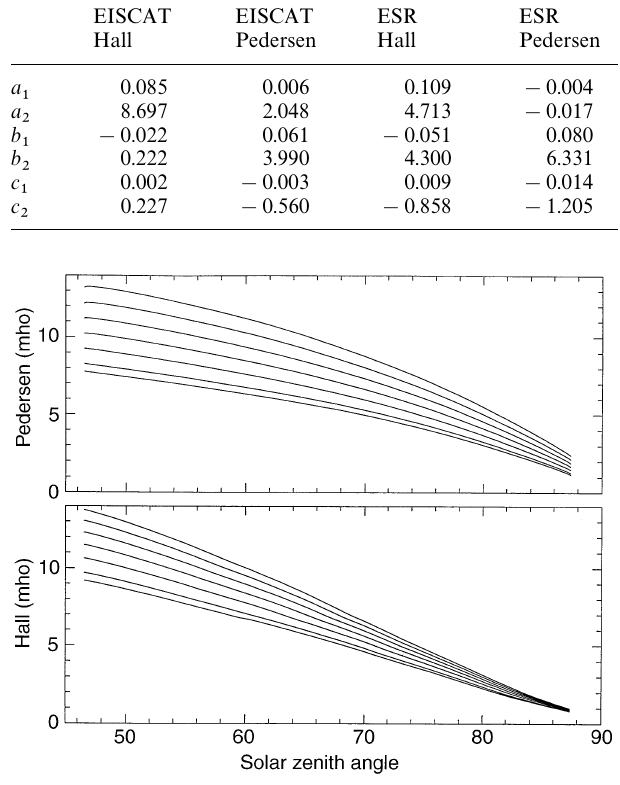
Fig. 7. We show the conductances versus solar zenith angle for seven different solar activities (from bottom to top: f (cid:49)(cid:48)(cid:46)(cid:55) " 70, 80, 100, 120, 140, 160, 180) fitted with a second-order polynomial in cos (cid:48)(cid:46)(cid:53) (cid:115) an offset. The variation of the coefficients versus f (cid:49)(cid:48)(cid:46)(cid:55) was considered to be linear (other dependencies proved not to